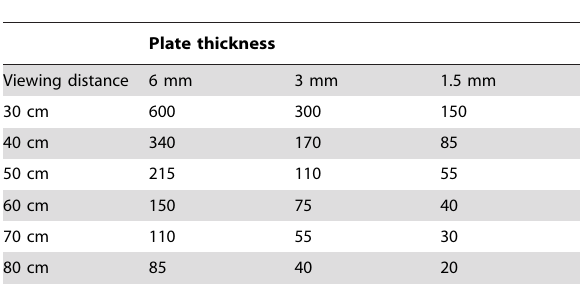
Table 3. Viewing distances and resulting disparities (arcsec) for the Frisby stereo test, reproduced from the test